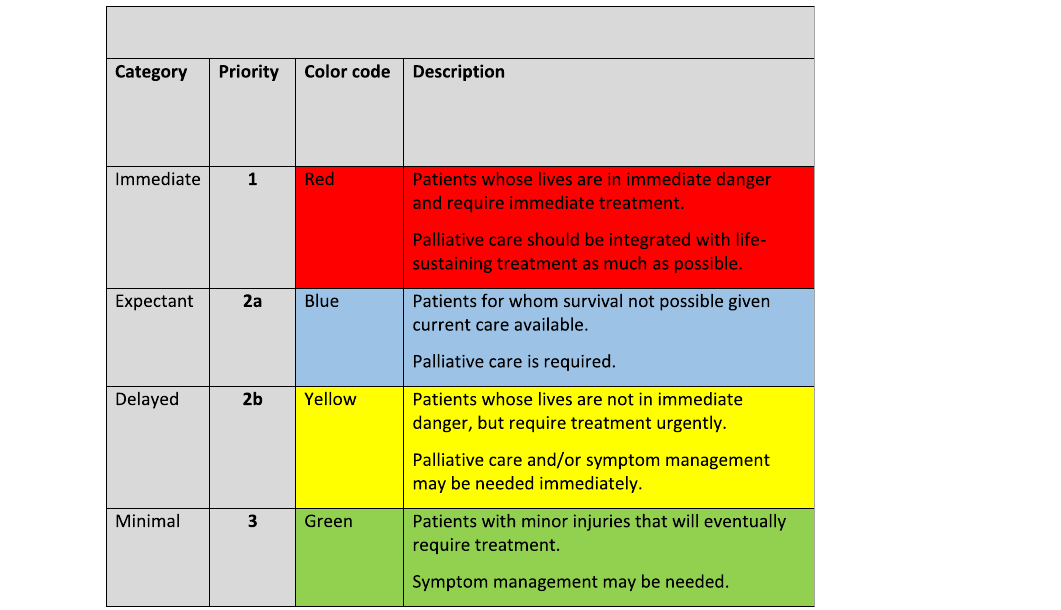
Table 1 Recommended triage categories in disaster or crisis